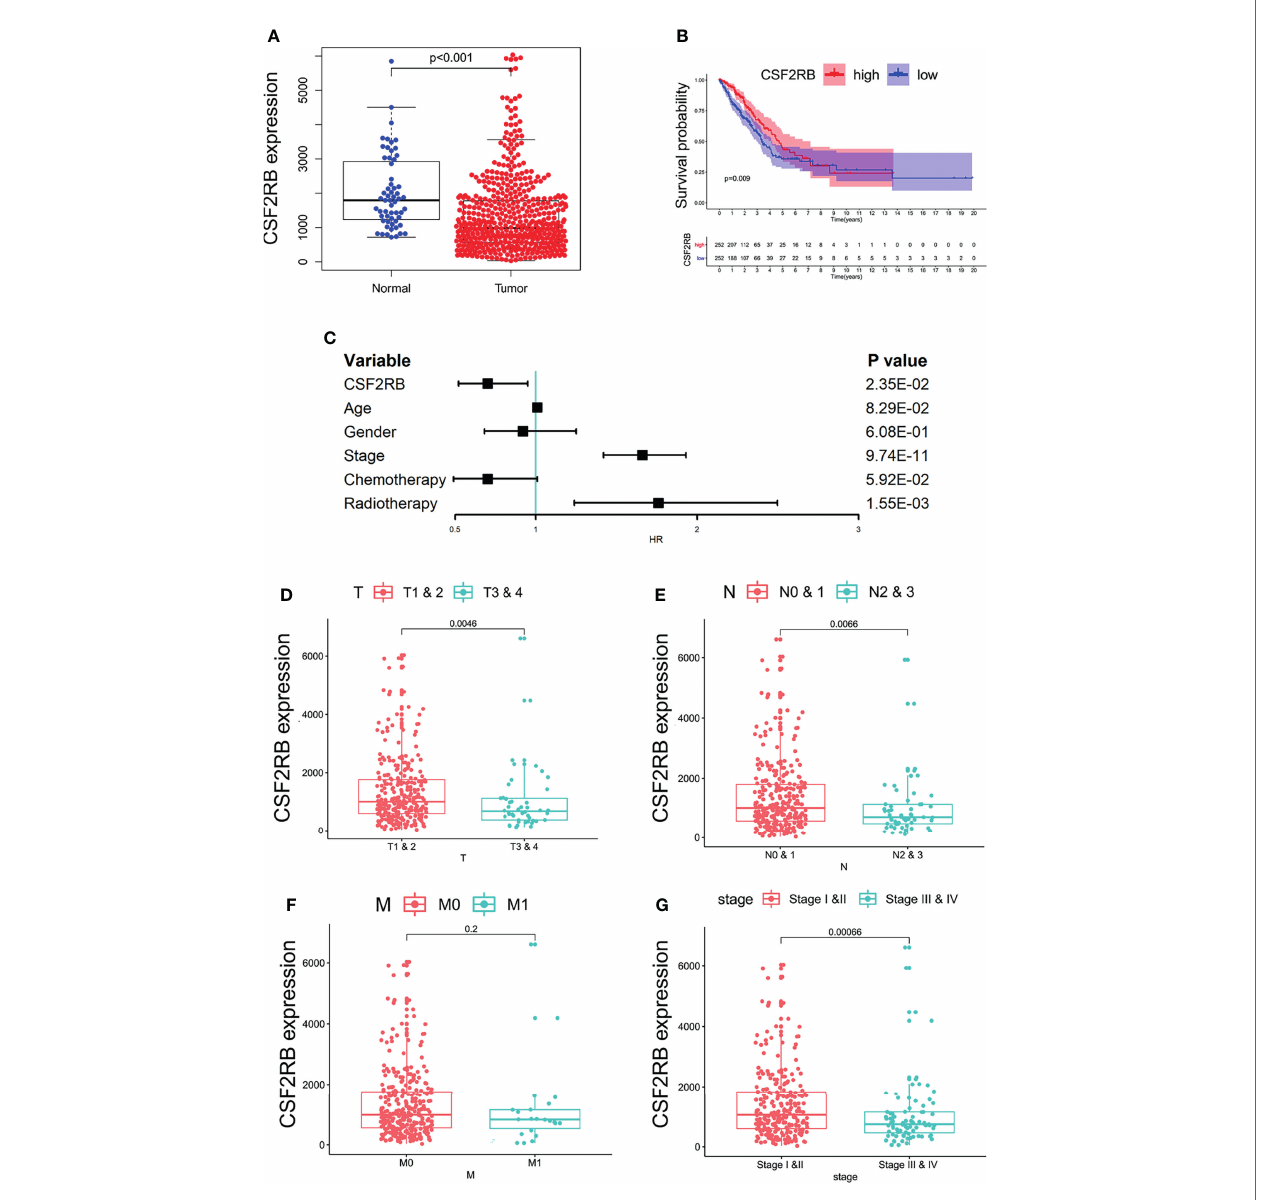
FIGURE 4 | The relationship between the expression of CSF2RB and clinical characteristics. (A) The expression of CSF2RB in lung adenocarcinoma tumor tissue and normal tissues. (B) A Kaplan – Meier analysis, in which the red line indicates the group with higher expression of this gene, and the blue line indicates the group with lower expression. (C) Multivariate cox regression analysis associated with survival. ( D – G) Relationship between clinical characteristics and the CSF2RB